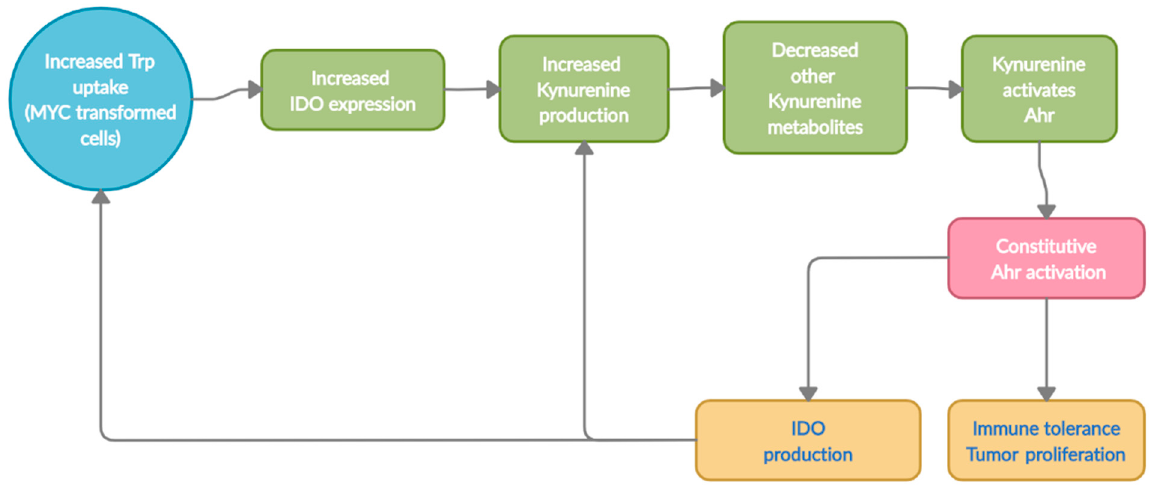
Figure 3. Sequential representation of Trp metabolism in Tumors (host cells).